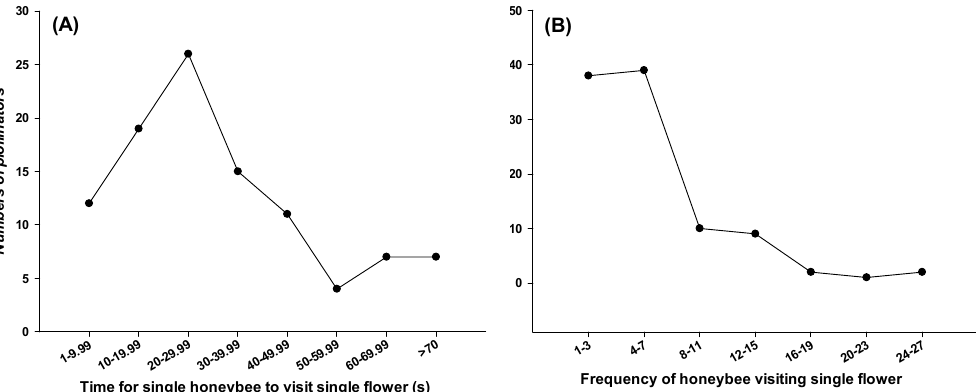
Figure 1. Pollination behavior of A. mellifera . ( A ) Time for a single honeybee to visit a single flower. ( B ) Frequency of honeybees visiting a single flower.